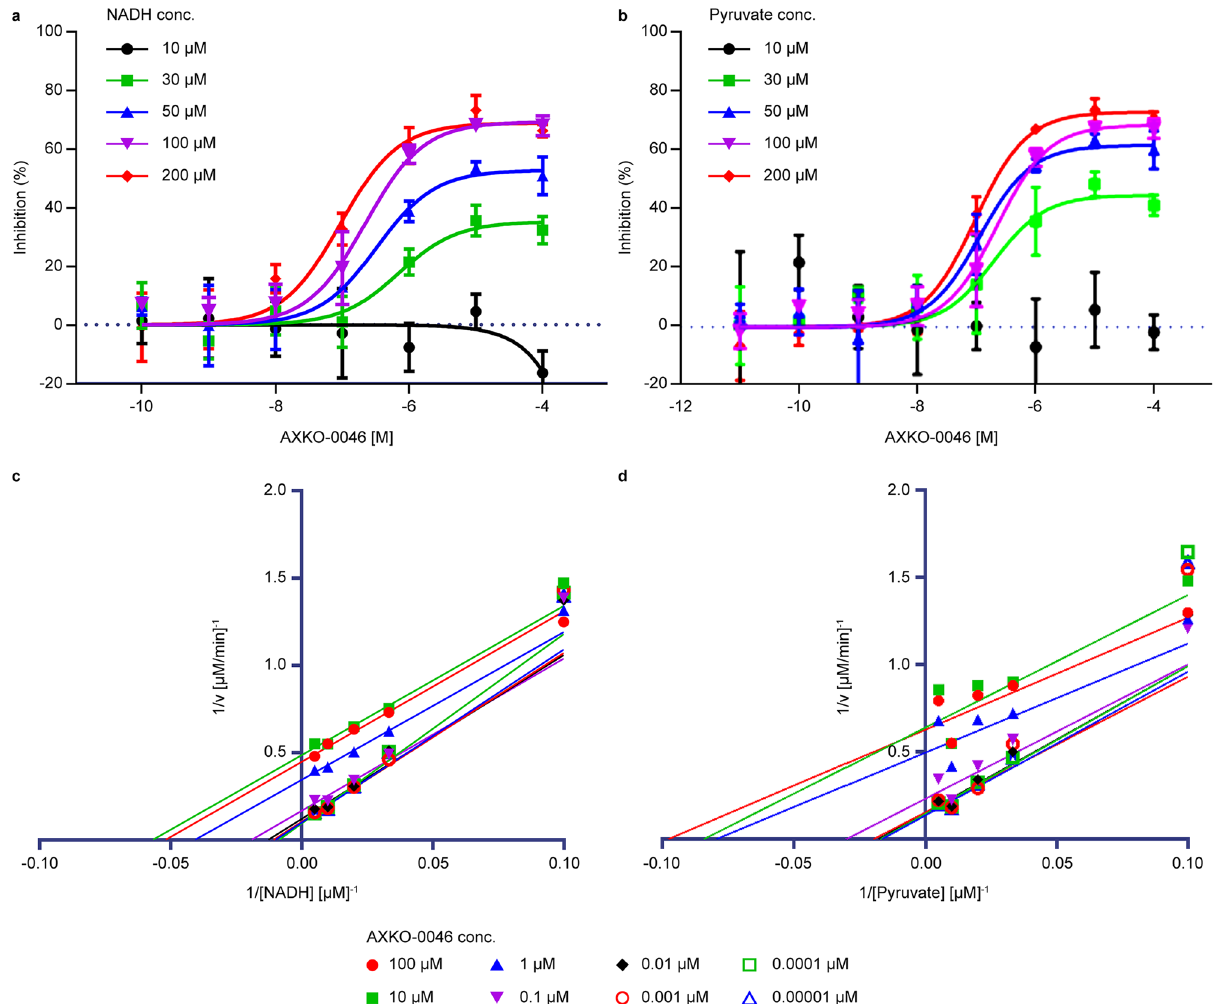
Figure 3. Biochemical characterisation of AXKO-0046. ( a,b) LDHB inhibition by AXKO0046 was studied using varying concentrations of ( a ) NADH and ( b ) pyruvate. The EC 50 values of AXKO-0046 decreased with increasing pyruvate and NADH concentrations. Data shown are mean ± standard deviation (n = 3). ( c,d) Lineweaver–Burk plots of the kinetic data in Table 1 with nonlinear regression analysis of ( c ) NADH and ( d )